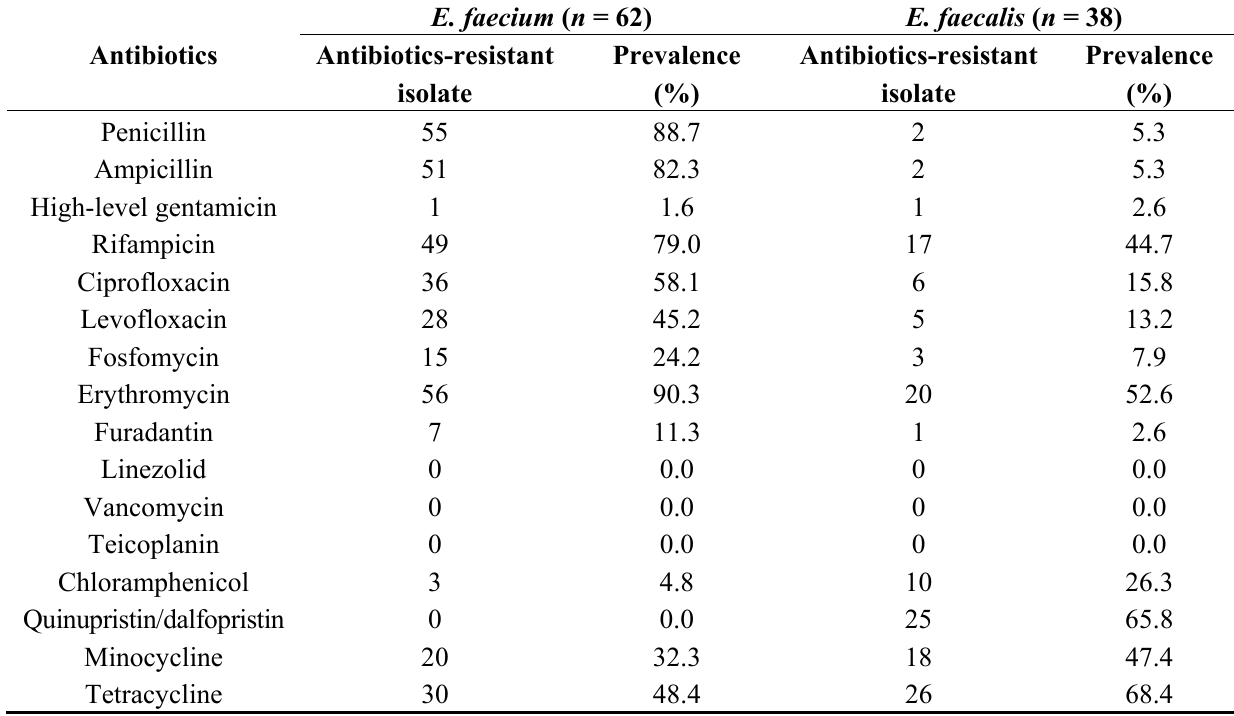
Table 1. Antimicrobial resistance in 100 isolates of E. faecium and E. faecalis . Antibiotics